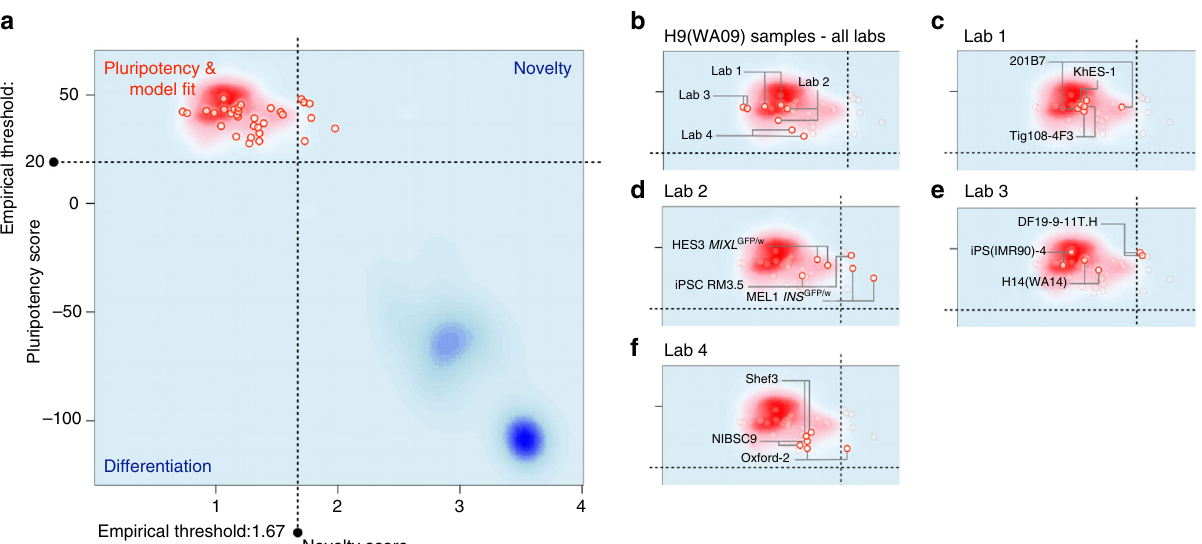
Fig. 2 Pluritest. a All PluriTest results from this study (red circles) are based on normalization to the H9 samples and were plotted on the background of the empirical density distribution of all pluripotent (red cloud) and differentiated samples (blue clouds) in the PluriTest training dataset 18 . b – f highlight the subsets of samples included in this study: All results from the same hPSC line (H9) cultured at each laboratory ( b ). Samples from Lab 1 ( c ), Lab 2 ( d ), Lab 3 ( e ), Lab 4 ( f ) are highlighted speci fi cally. All cell lines are above the Pluripotency Score threshold ( θ P > = 20). Both replicates of two cell lines MEL1 INS GFP/w in d and DF19-9-11T.H in e score above the Novelty threshold ( θ = 1.67) and thus would be highlighted for further investigation. Three cell lines N > show larger differences between the novelty scores of their respective replicate samples 201B7 in c , RM3.5 C in d , and Oxford-2 in